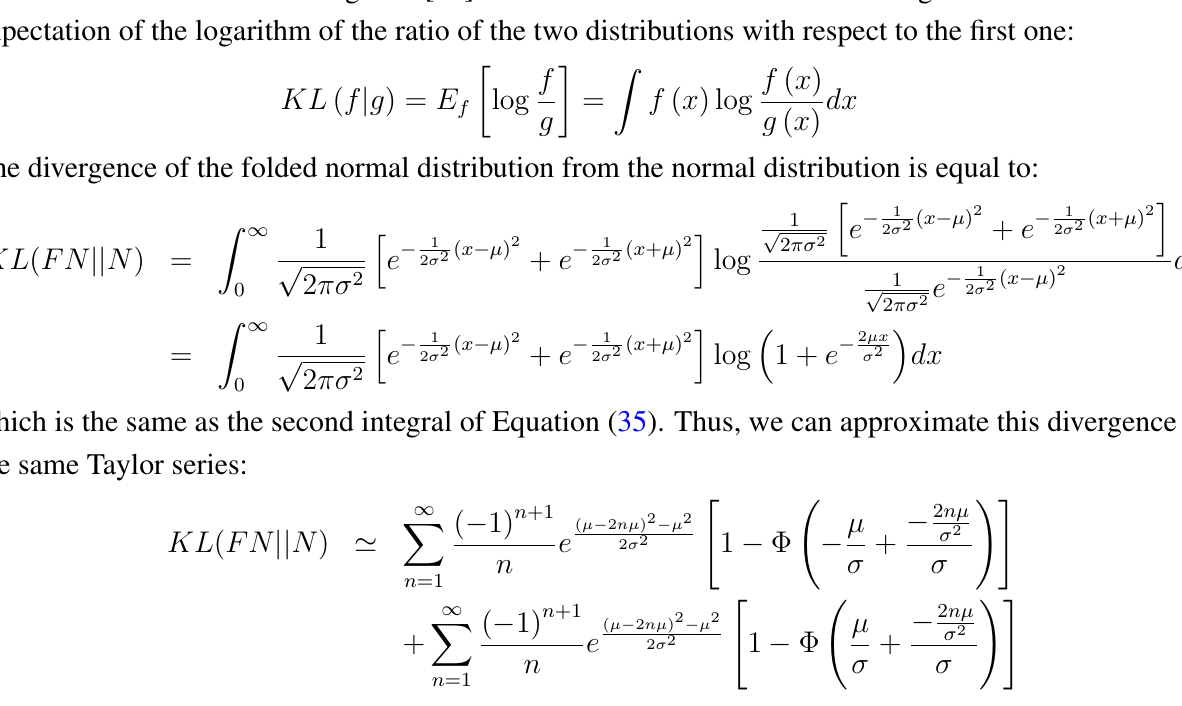
Figure 3. Kullback–Leibler divergence from the normal for a range of values of θ = µ σ = 1 ( a ) and σ = 5 ( b